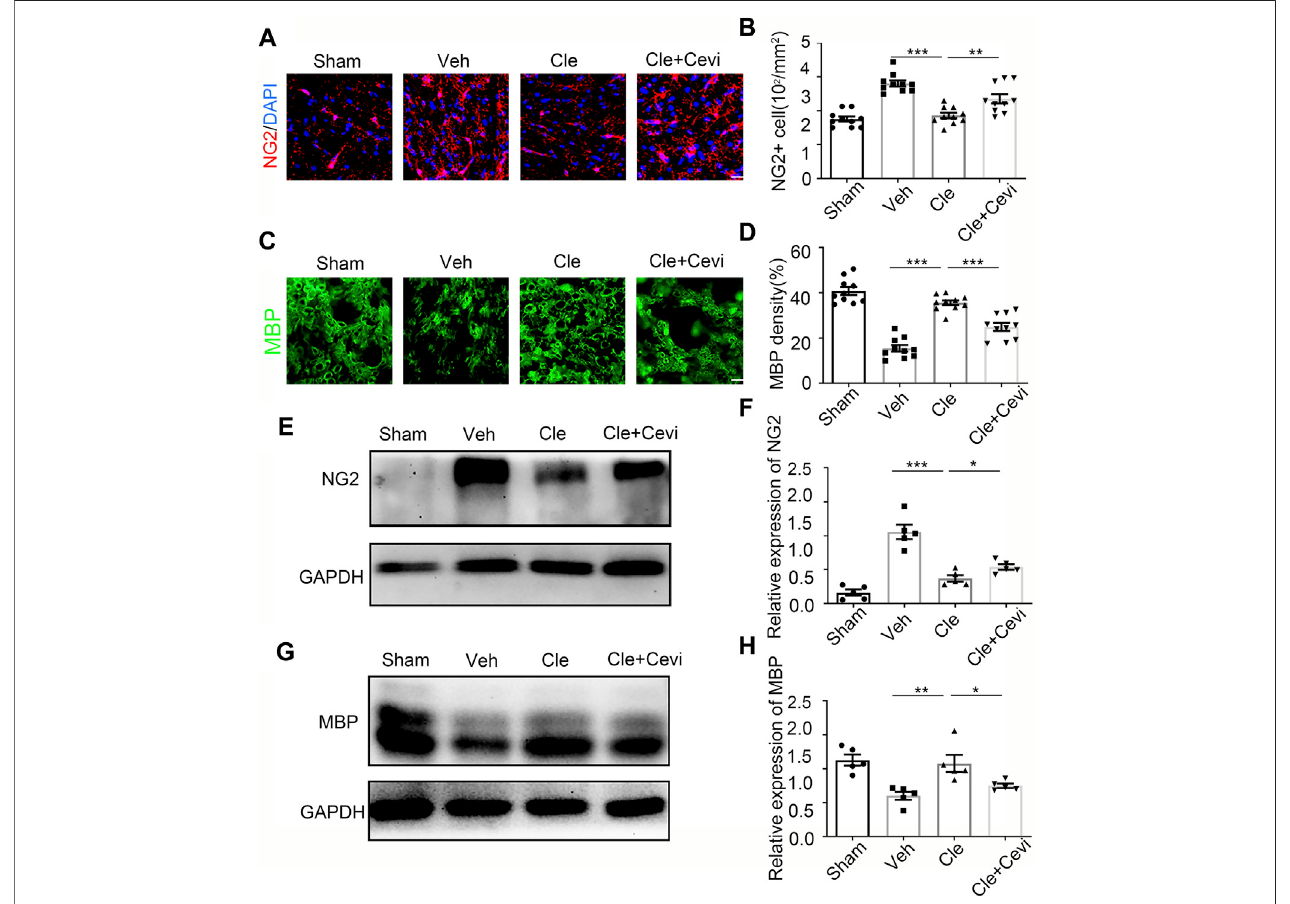
FIGURE2| Clemastinepromotesthedifferentiationofoligodendrocyteprogenitorcellsat14dpiinSCI. (A,C) RepresentativeimagesshowingNG2-positiveOPCs (A) and area of MBP-positive mature OLs (C) in the spinal cords of Sham, Veh, Cle, and Cle + Cevi rats at 14 dpi. Scale bar, 50 µm. (B,D) Quanti fi cation of NG2+ cell numbers and MBP density from each group ( n = 4). (E,G) Representative immunoblots of NG2 (E) and MBP (G) in the indicated situation. (F,H) Quantitative analysis of theexpressionofNG2 (F) andMBP (H) intheindicatedsituation.GAPDHexpressionfromthesamesampleactsasaninternalcontrol.Errorbarsrepresentmean± SEM, signi fi cance based on Student ’ s t-test with the respective controls (* p < 0.05, ** p < 0.01, and *** p < 0.001, n = 5 for each group at 14 dpi).